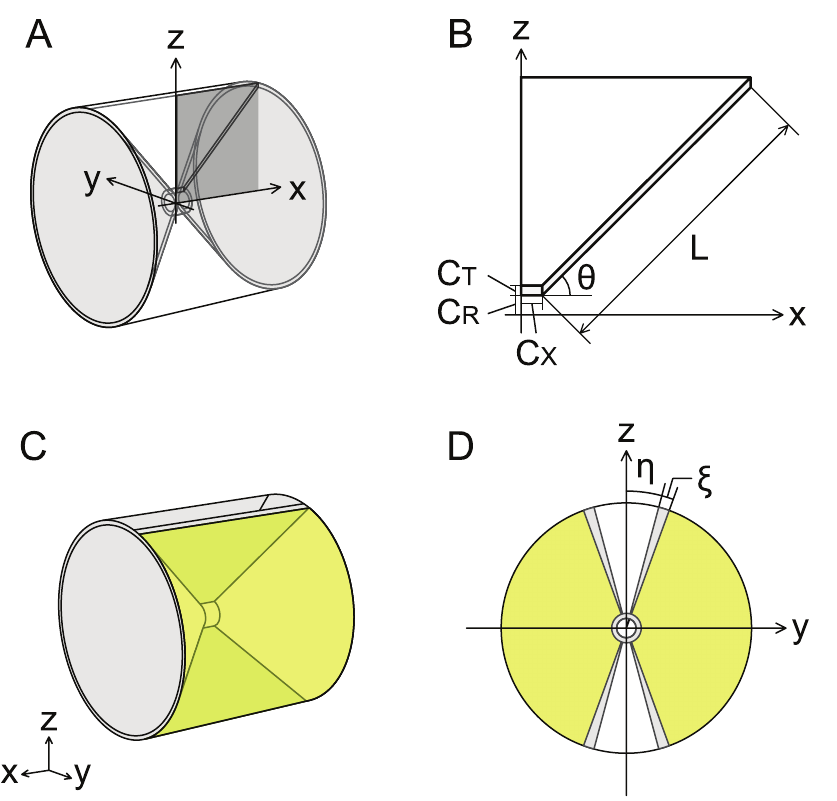
Fig 2. Simulation model. (A) Transparent view of entire structure. The light gray domain corresponds to the autocentrum. (B) Quarter cross-section of analysis domain on zx plane (dark gray plane in (A)). (C) Entire structure. The yellow-colored area is the design domain. (D) Transverse section at midpoint of analysis domain. The light gray wedge-shaped regions represent the vertebral arches. The geometric parameters are described in Table 1.